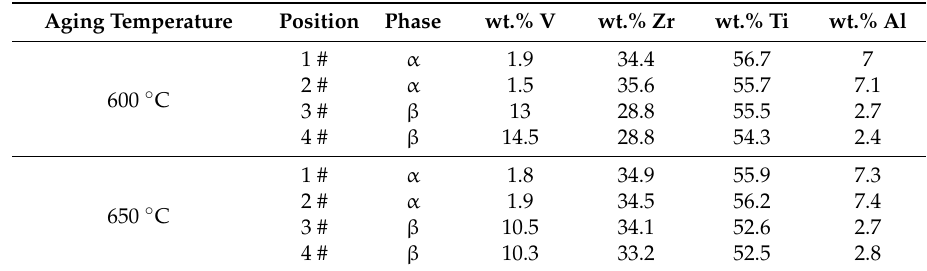
Figure 11. Microstructural feature of the Ti6Al4V30Zr alloy after aging at 600 °C : ( a ) bright field (BF) image; ( b ) SAD pattern with [111] β zone axis; ( c , d ) HAADF-STEM images showing α phase; ( e ) the EDS mapping of Zr, V, Al, and Ti atoms; ( f ) the composition profiles along the arrows shown in ( d ). Table 2. Chemical composition of the α phase and the β phase in the Ti6Al4V30Zr alloy after aging at 600/650 °C (as shown in Figures 11d and 12d).